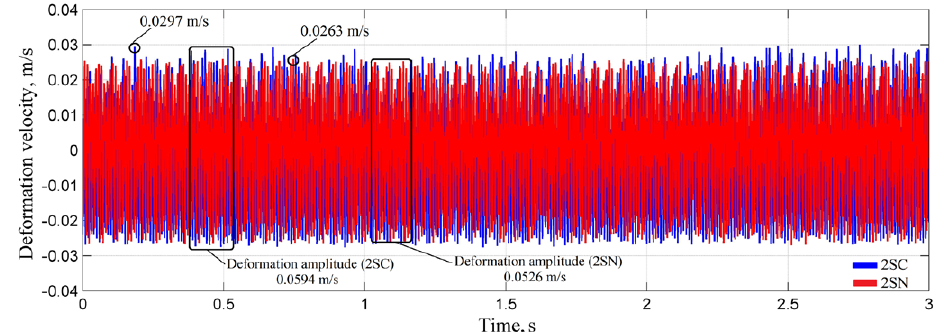
Figure 6. The outer surface displacement velocity of high-pressure hoses